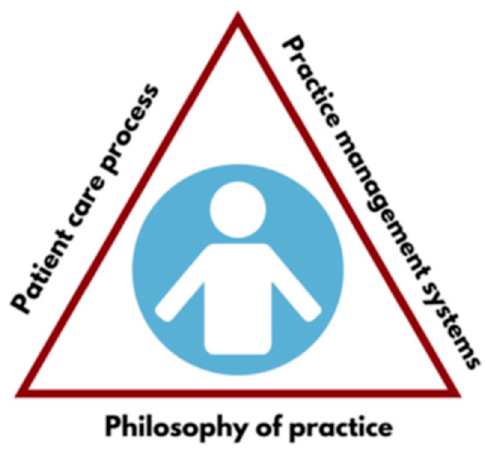
Figure 2. Comprehensive Medication Management framework [48].